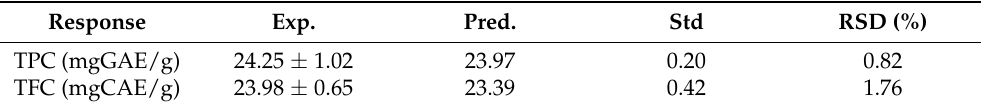
Figure 2. Desirability surface plot: as a function of ( A ) ethanol concentration and extraction time; ( B ) ethanol concentration and extraction temperature; ( C ) extraction time and temperature. Table 3. Experiment data of the validation of predicted values at optimal extraction conditions of URADP.